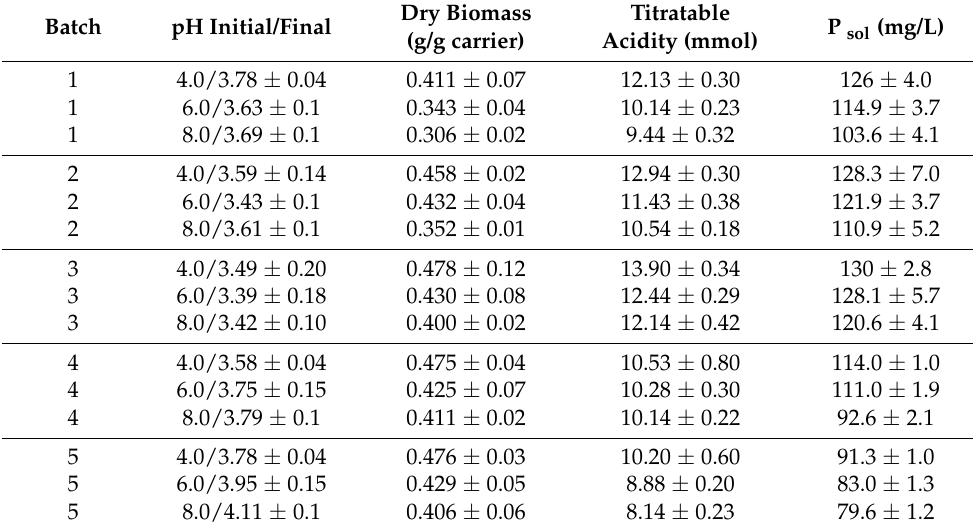
Table 1. Effect of pH on biomass growth, titratable acidity, and P-solubilization activity of P. bilaiae immobilized in alginate beads.